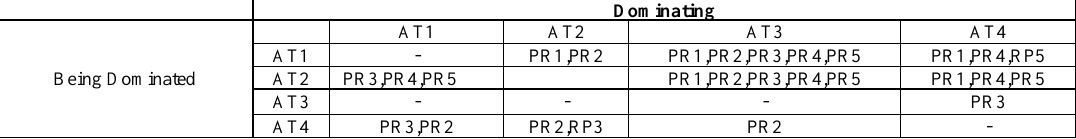
Table 25. Dominating interaction matrix - ranking of actors with reference to the process.